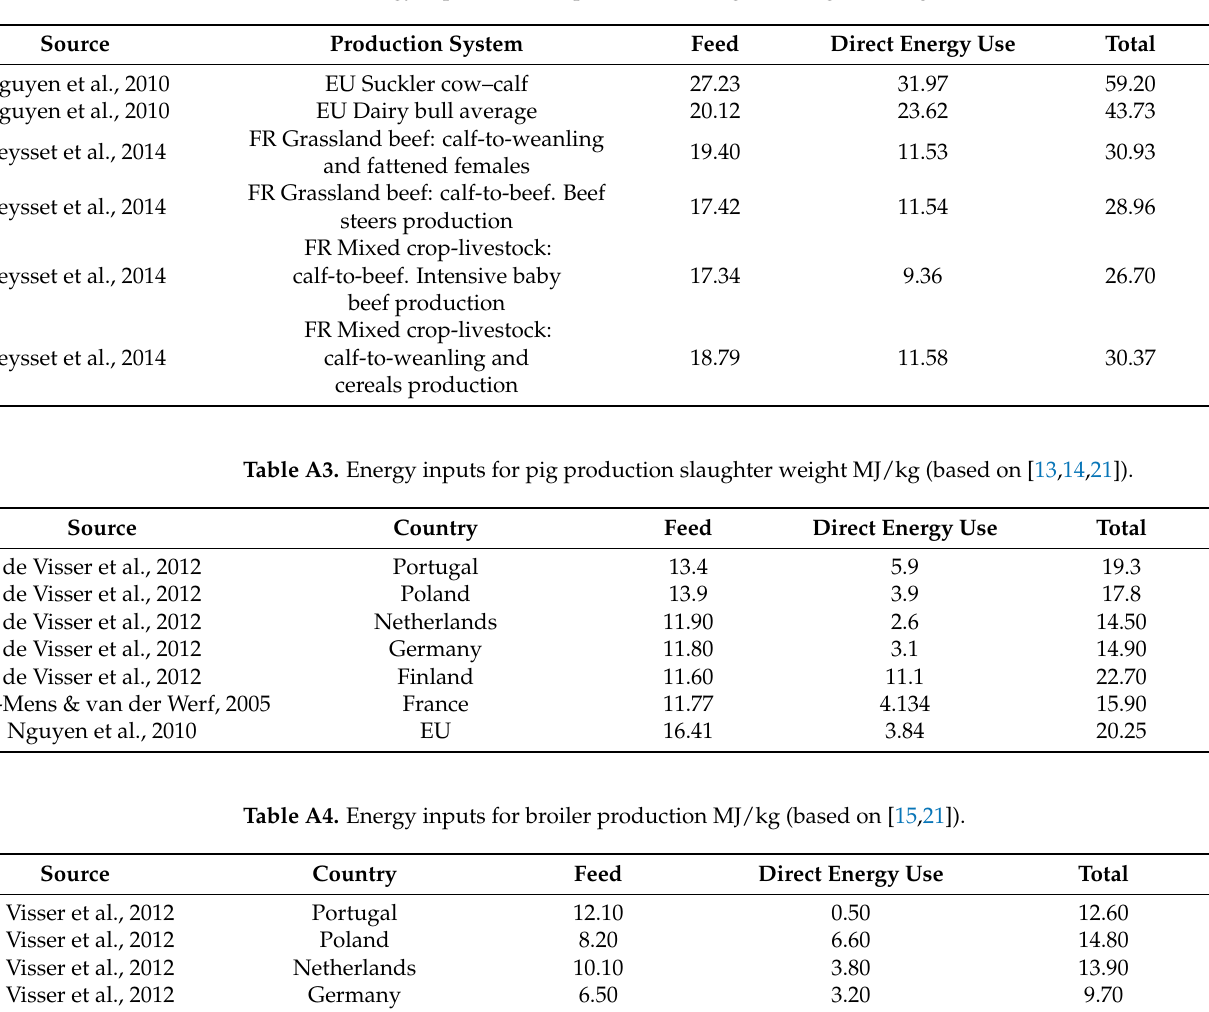
Table A2. Energy Inputs for beef production slaughter weight MJ/kg (based on [12,20]).